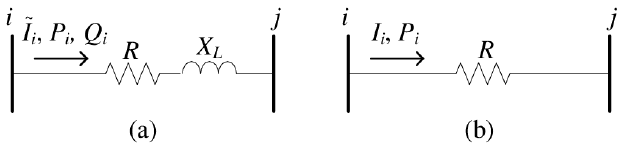
Figure 1. (a) AC and (b) DC unit circuits. Figure 1. ( a ) AC and ( b ) DC unit